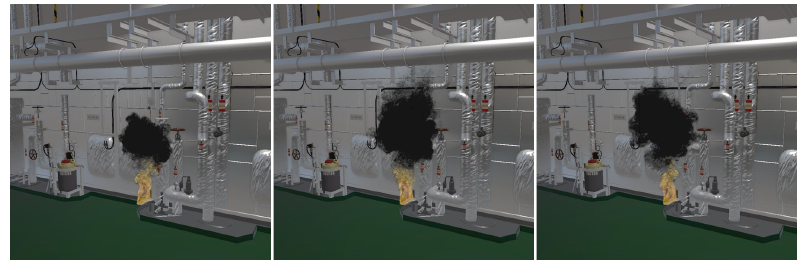
Figure 12. The spread engine